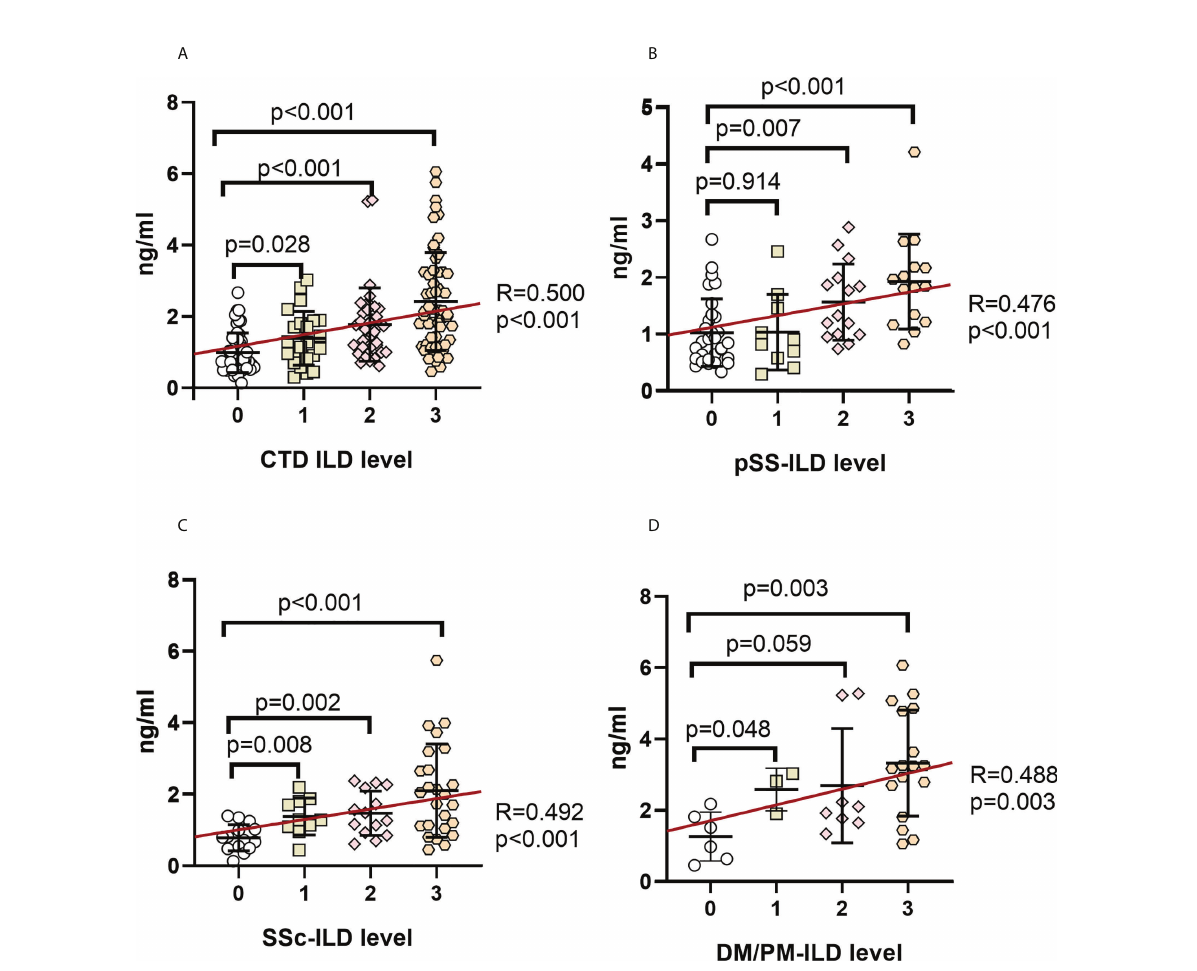
FIGURE 3 Correlation between serum MUC5AC levels and ILD severity in patients with various autoimmune disease(s) (A) CTD-ILD. (B). pSS-ILD. (C). SSc- ILD. (D). DM/PM-ILD. Dot plot depicts the correlation between the level of MUC5AC and the severity of ILD in individual serum samples from patients with no ILD (interstitial lung abnormality (ILD score 0), uncertain ILD (ILD score 1), mild ILD (ILD score 2), or advanced ILD (ILD score 3) (measured by standard solid-phase enzyme-linked immunosorbent assay). Each symbol represents an individual patient; horizontal lines show the mean. Categorical variables were tested by using the Chi-square test and Fisher ’ s exact test. Statistical signi fi cance was determined using two-tailed tests and